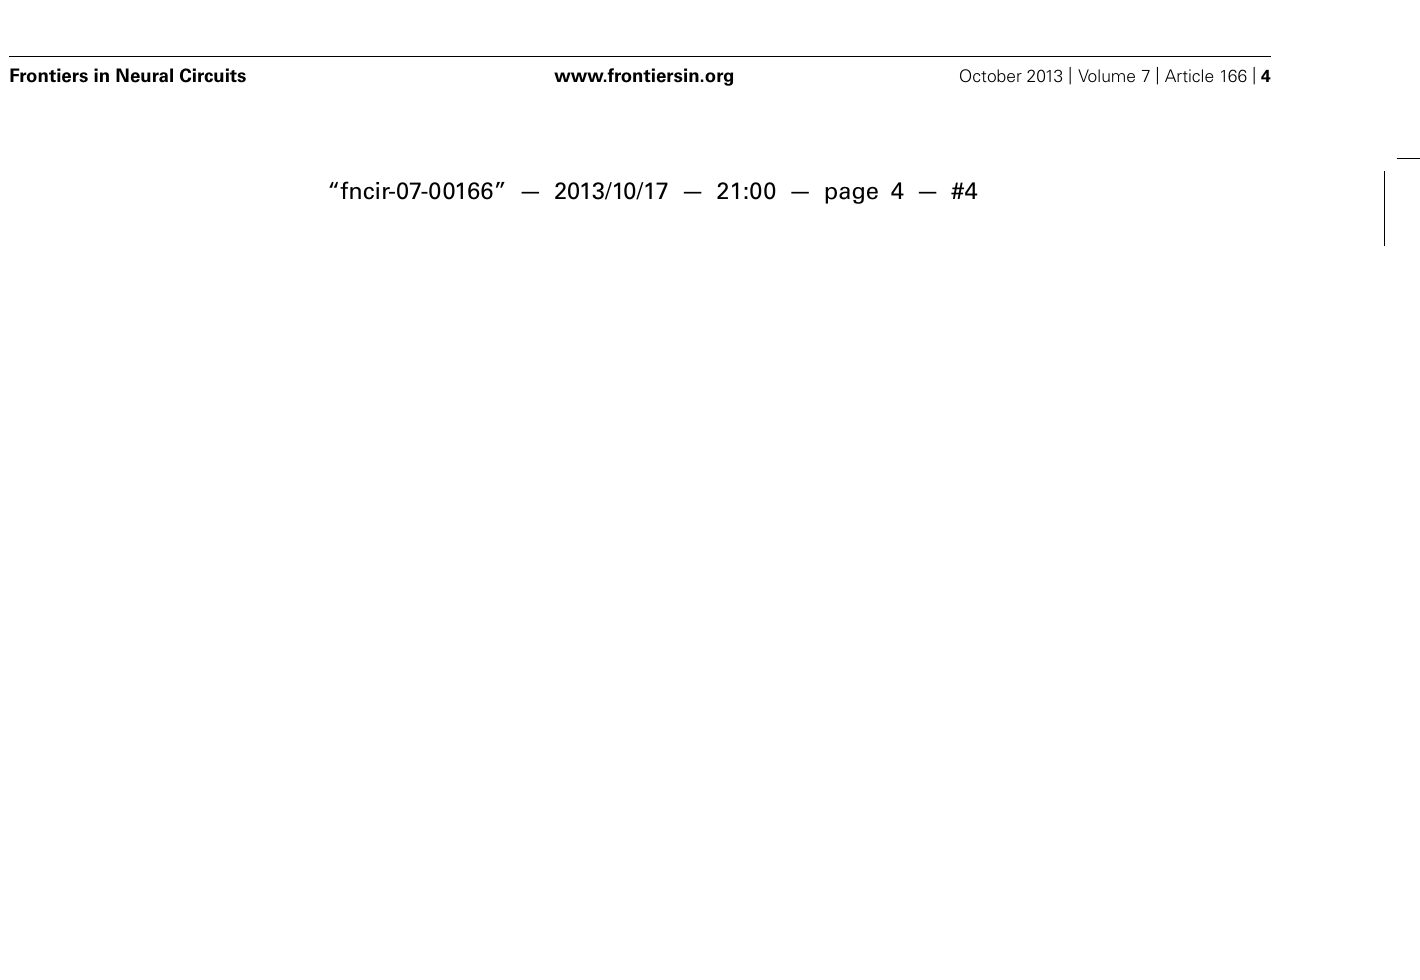
cover a wide spectral range but differ in their spectral and temporal characteristics. The vocalizations presented to the animals were bandpass filtered (500 Hz to 40 kHz) and calibrated with respect to the speaker–ear